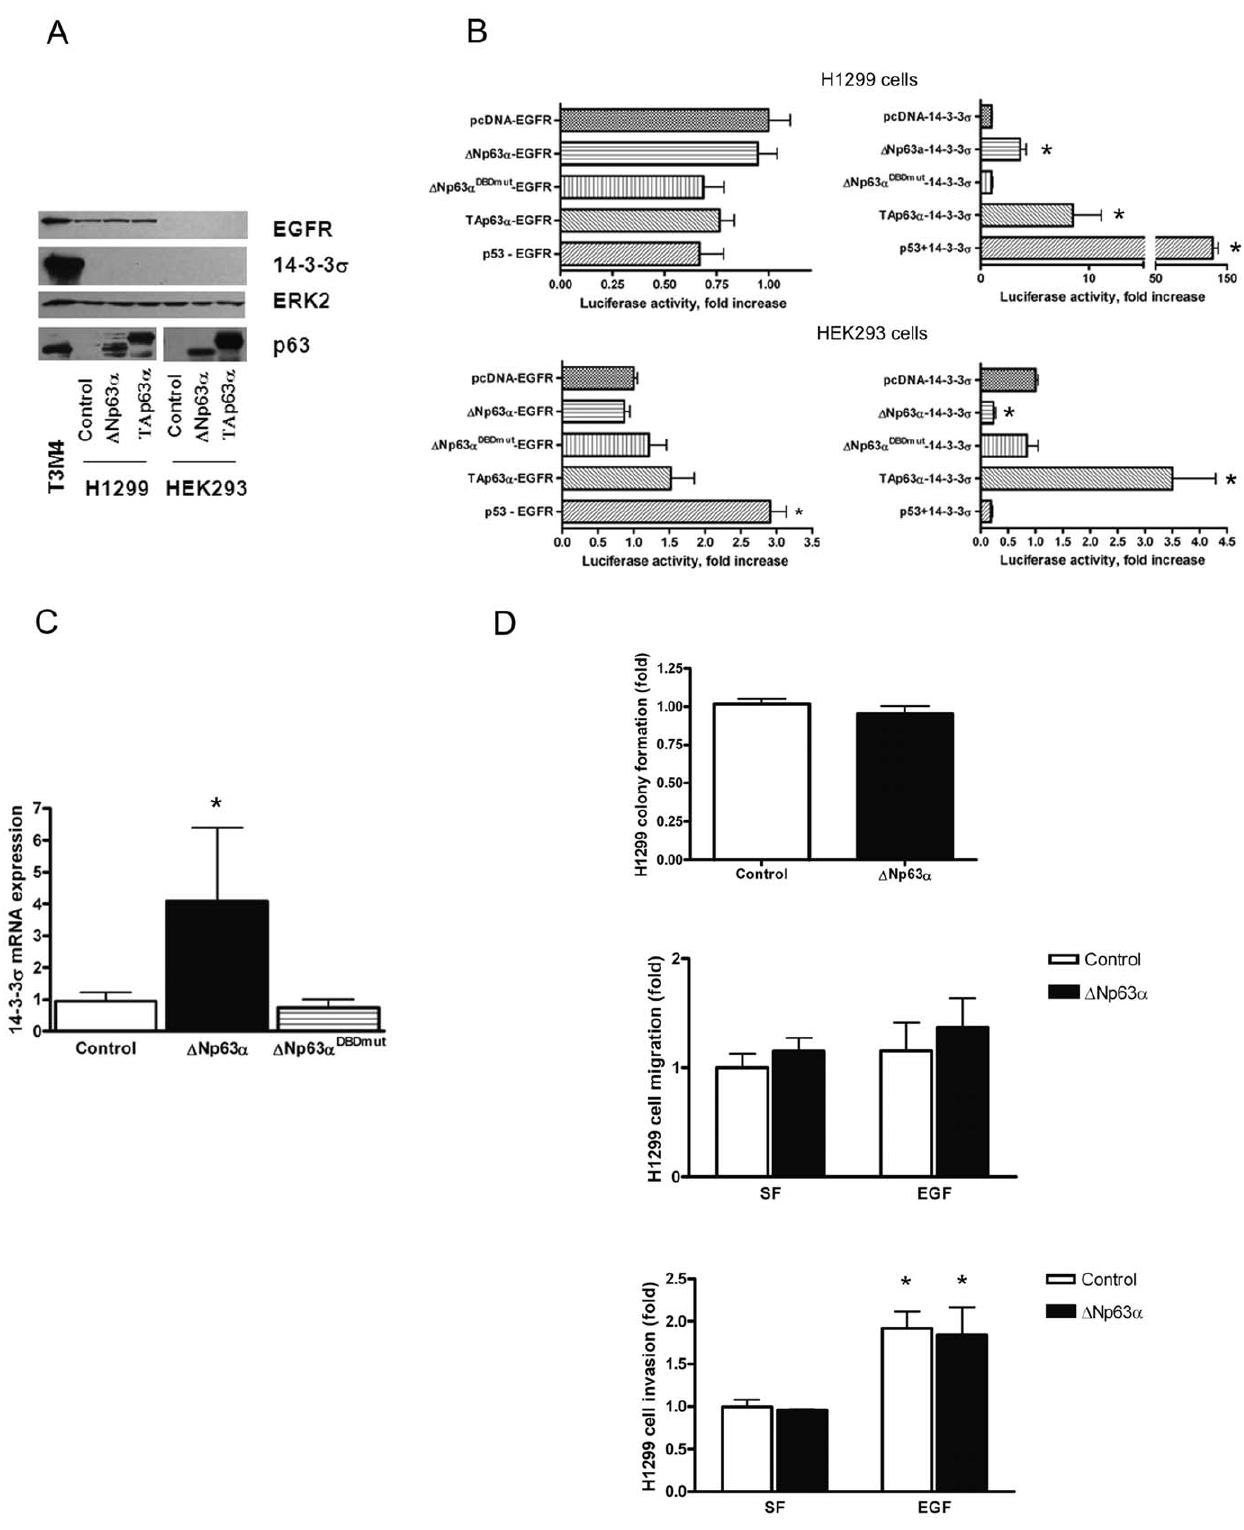
Figure 7. A distinct role of D Np63 a in HEK293 and H1299 cells. A , D Np63 a does not affect EGFR or 14-3-3 s protein levels in HEK293 or H1299 cells. Representative blot of three independent experiments is shown. B , D Np63 a fails to upregulate EGFR promoter but modulates 14-3-3 s promoter in a luciferase reporter assay. Cells were transfected with wildtype EGFR or 14-3-3 s promoter luciferase construct as indicated, along with pCMV b plasmid, with or without wildtype p53, D Np63 a , D Np63 a DBDmut , or TAp63 a . At 48–72 h after transfection, the luciferase activity was determined. The transfection efficiency was standardized against b -galactosidase activity. Results are indicative of three independent experiments performed in duplicates. C , D Np63 a increases 14-3-3 s mRNA transcript levels in H1299 cells. H1299 cells were transfected with D Np63 a , D Np63 a DBDmut or vector